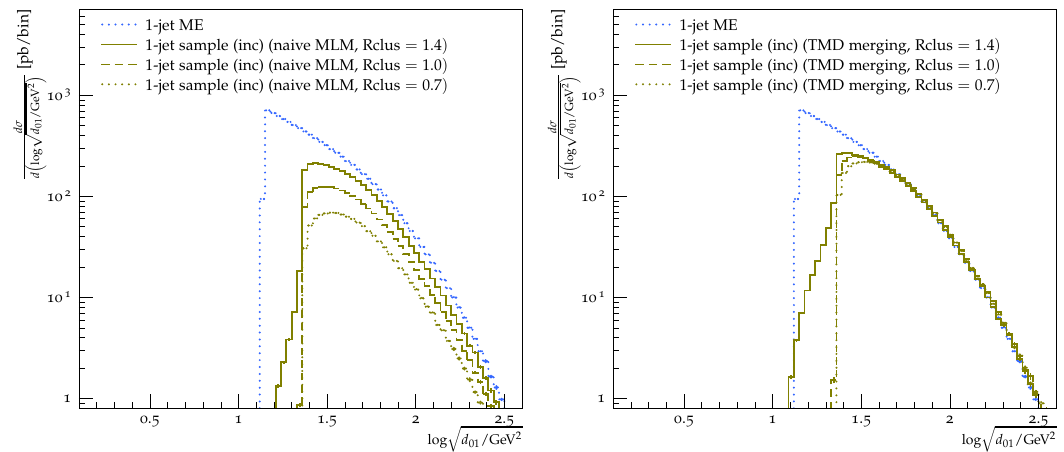
Figure 3 . The d 01 spectrum at parton level, where d 01 represents the energy-square scale at which a 0 -jet event is resolved as a 1 -jet event in the k jet-clustering algorithm. The dotted blue curve ⊥ represents the ME level of the Z + 1 jet calculation, while the green curves represent the Z + 1 jet result using the “naive MLM” (left) and TMD merging (right) methods for different values of the R clus parameter. The predictions are computed in inclusive (inc)